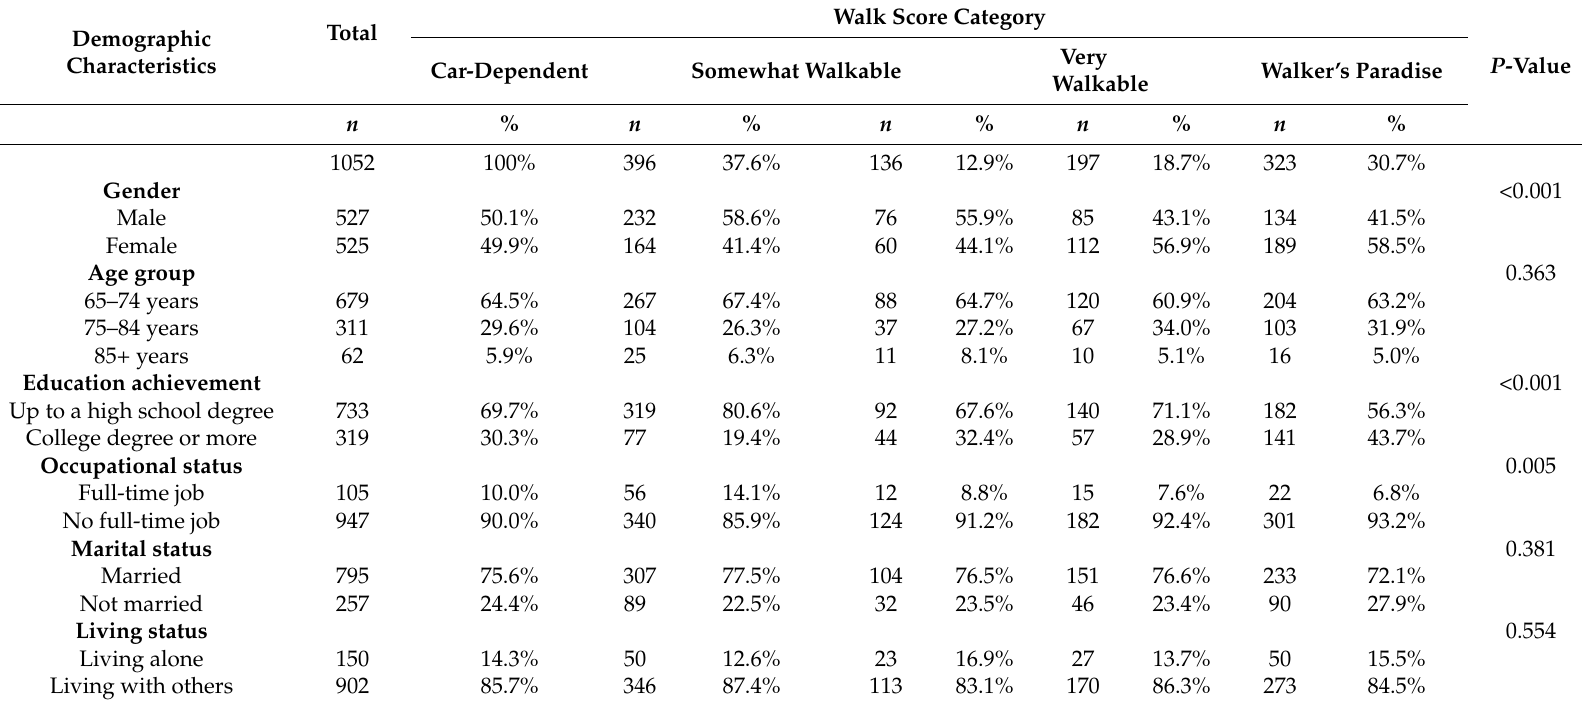
Table 1. Demographic characteristics of participants by walk score category ( n =